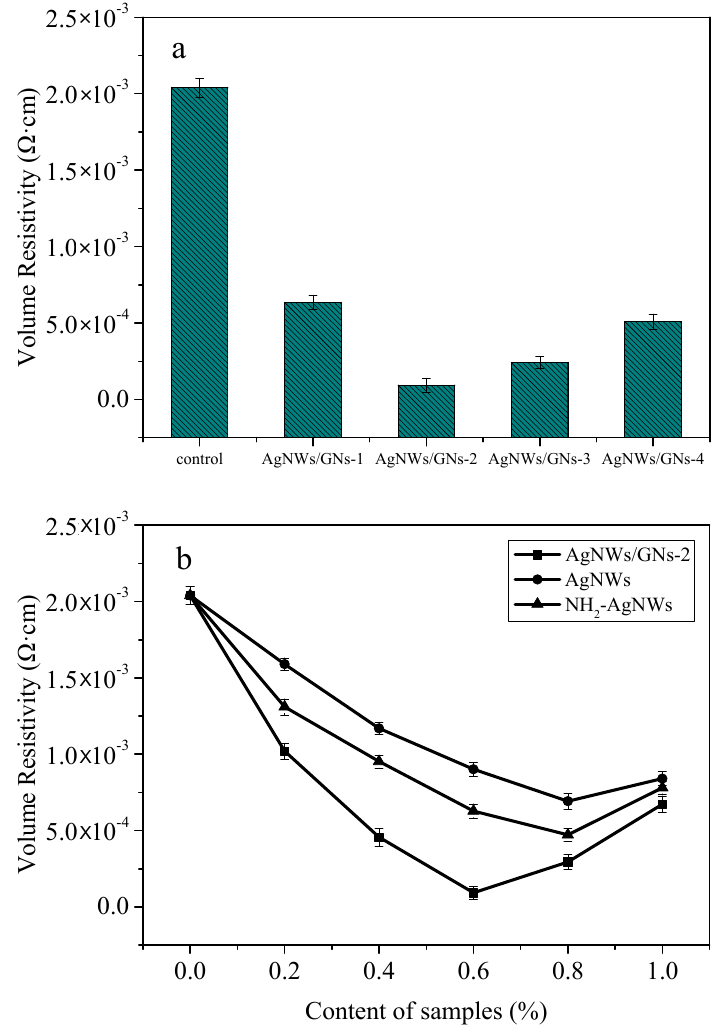
Figure 10. Volume resistivity of the ECAs filled with the nanocomposites with different proportions of AgNWs to GO ( a ) and different contents of the samples ( b ).